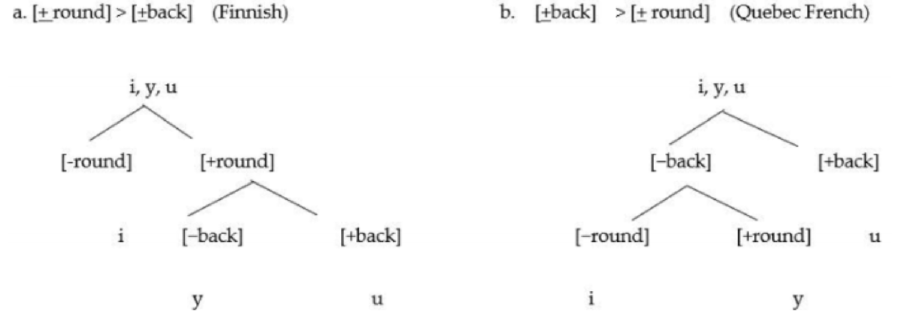
Figure 1. Two possible contrastive hierarchies for a 3-vowel